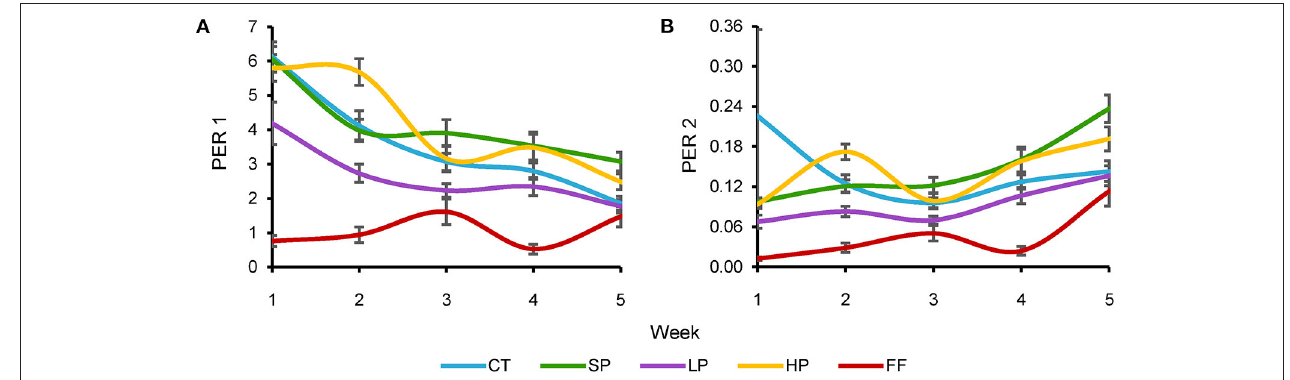
FIGURE 3 | Protein Efficiency Ratios. PER1, (A) = weight gained (g)/protein consumed (g); PER2, (B) = weight gain (g)/food intake (g) × protein percentage (%).